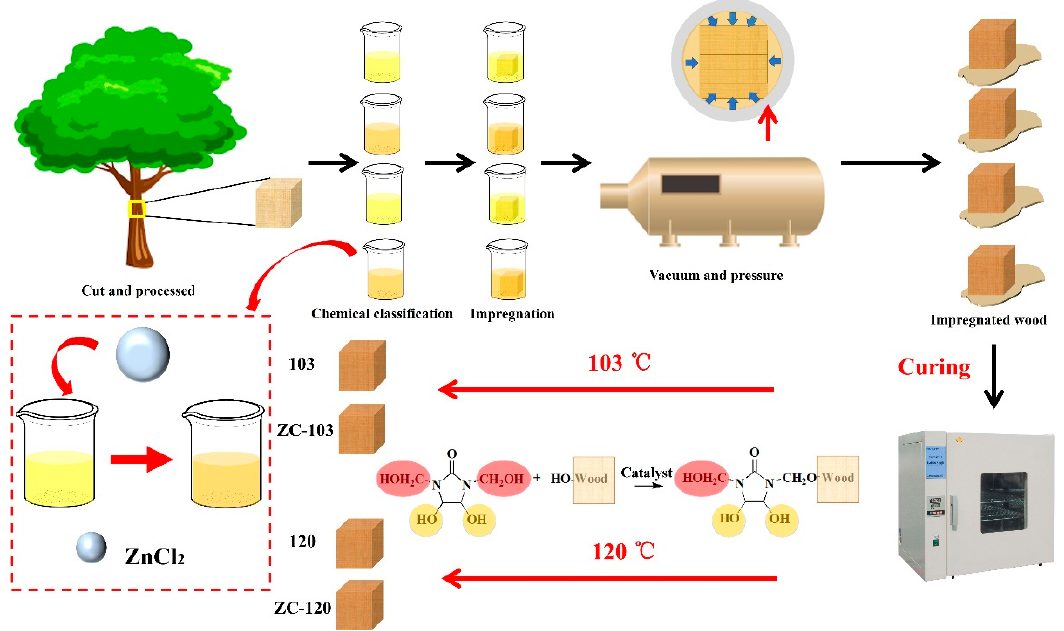
Figure 2. Experimental technology roadmap.